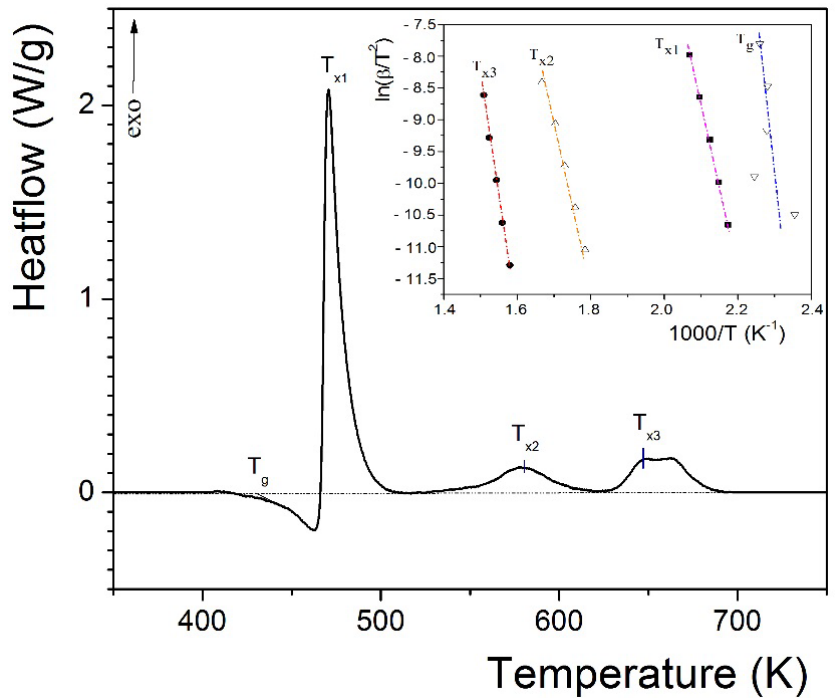
Figure 2. Continuous-heating DSC curve of the as-quenched Mg 65 Ni 20 Cu 5 Y 10 metallic glass obtained at 20 Kmin −1 . The inset shows Kissinger plots.